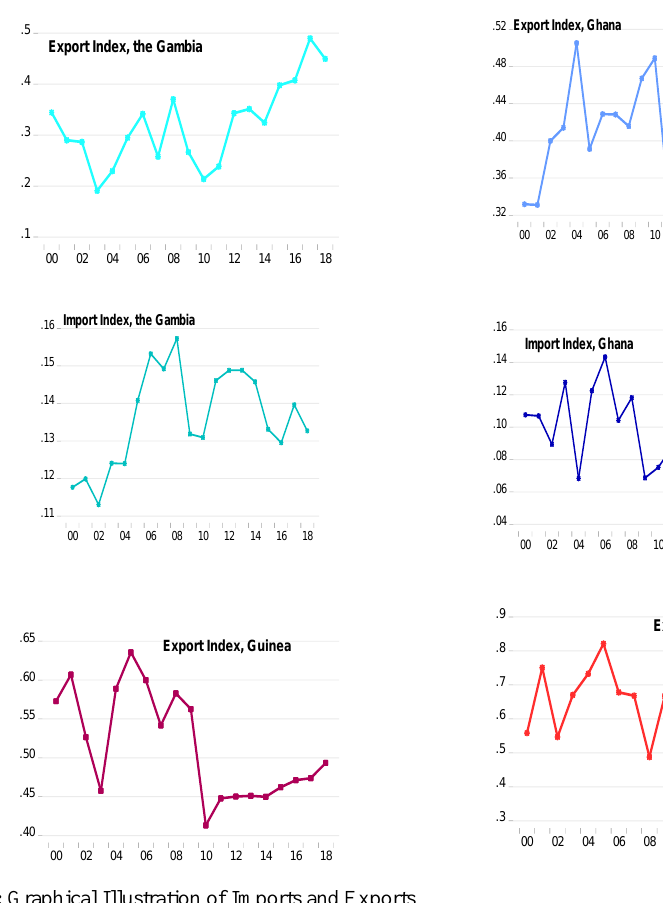
Figure 1: Graphical Illustration of Imports and Exports Concentration Index across Countries; Source: